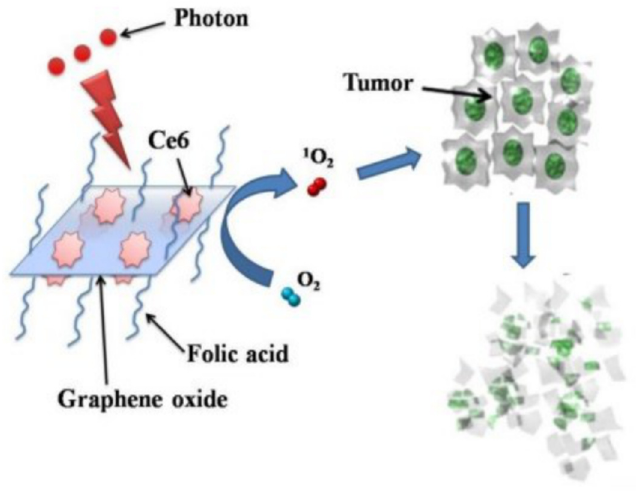
Figure 3. PS molecules of Chlorin e6 (Ce6) loaded by folic acid-conjugated GO for PDT applications in cells. Reproduced from Ref. [63] with permission from PubMed Central.